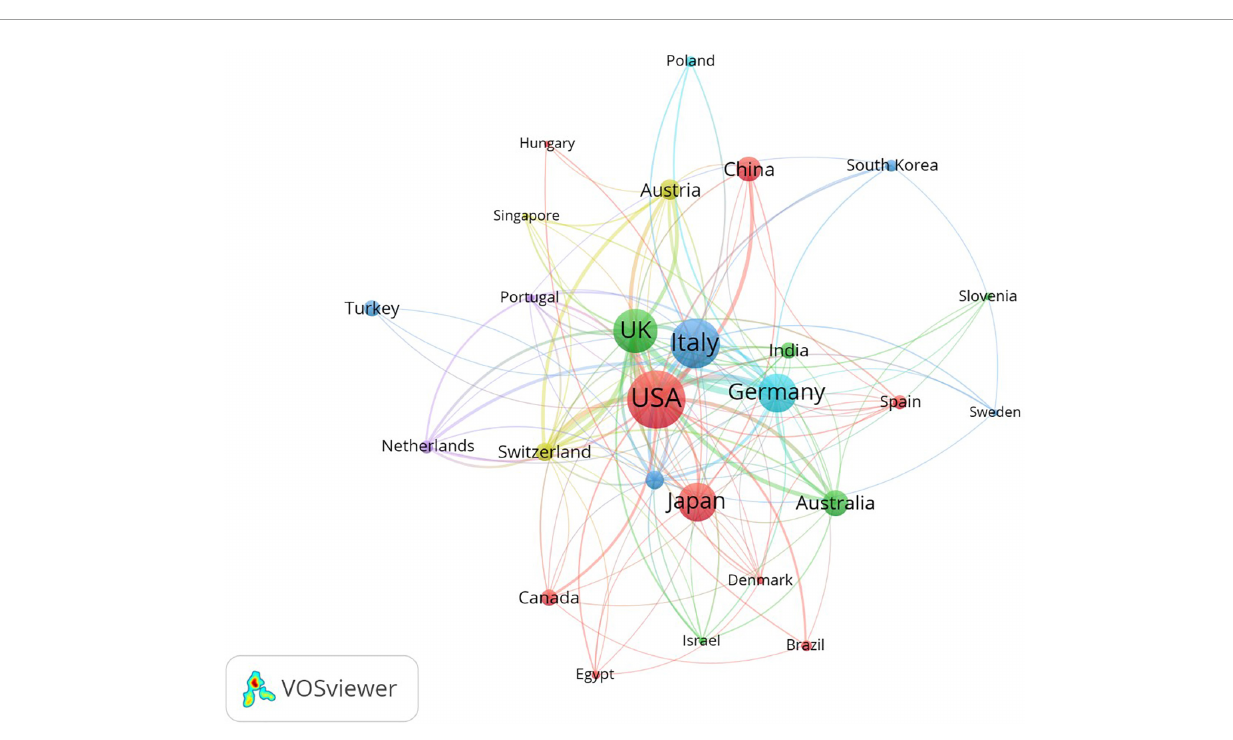
FIGURE6 The co-authorship analysis of countries involved in microperimetry research. The size of nodes demonstrated the number of publications by country. The curves between the nodes illustrated their co-operation. The shorter distance between the two nodes indicates a closer level of co-operation between the two